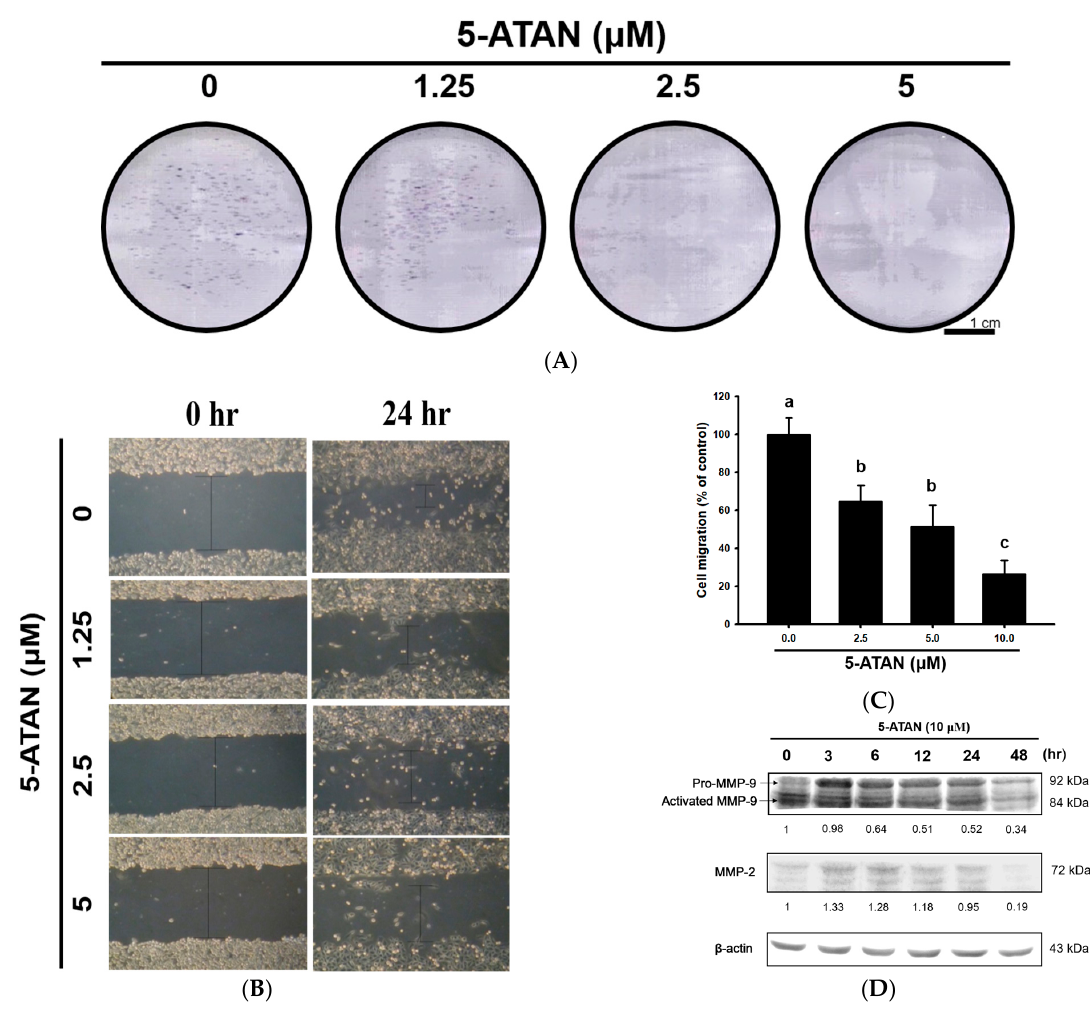
Figure 4. Effects of 5-ATAN on colony formation and cell migration in PC-3 cells. ( A ) Cells were treated with various concentrations of 5-ATAN, and the colonies formed were observed by crystal violet staining and photographed after 14 days of incubation. ( B ) Cell migration was analyzed by wound healing assay. Representative microphotographs of wound healing assay of PC-3 cells ex- posed to various concentrations of 5-ATAN at the beginning and end of incubation (0 and 24 h, respectively). ( C ) Quantification of cells that migrated into the wound is shown. Data were ex- pressed as mean ± SD of three determinations presented in the bar graph and analyzed statistically using ANOVA and Duncan’s test. Different letters represent statistical differences among treat- ments, p < 0.05. ( D ) The protein expression of MMP-2 and MMP-9 was analyzed by Western blot.